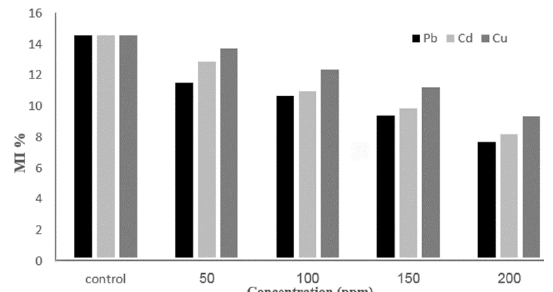
Fig. 2 . Correlation between MI and heavy metal